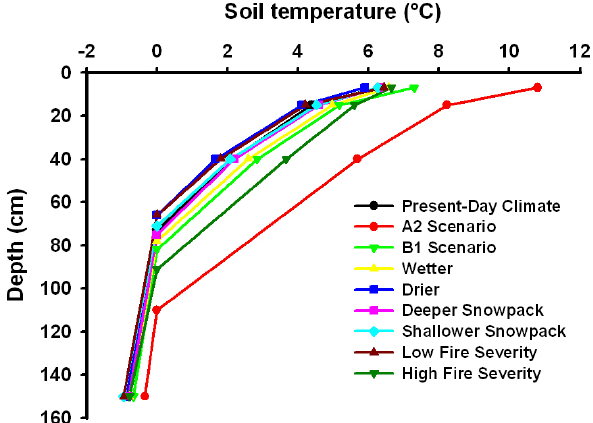
Fig. 5. Sensitivity of mean monthly temperature (MMT) in Au- gust to a suite of climatic and fire scenarios as modeled from GIPL. The depth of temperature data reflect positioning in shallow organic horizons ( < 10cm), deep organic horizons (15cm), unfrozen min- eral soil in the active layer (40cm), and permafrost (1.5m). August MMT were used at each depth were used to drive the temperature sensitivity of organic matter decomposition (Eqs. 1 and 2) in the Fire-C model across this suite of climate and disturbance